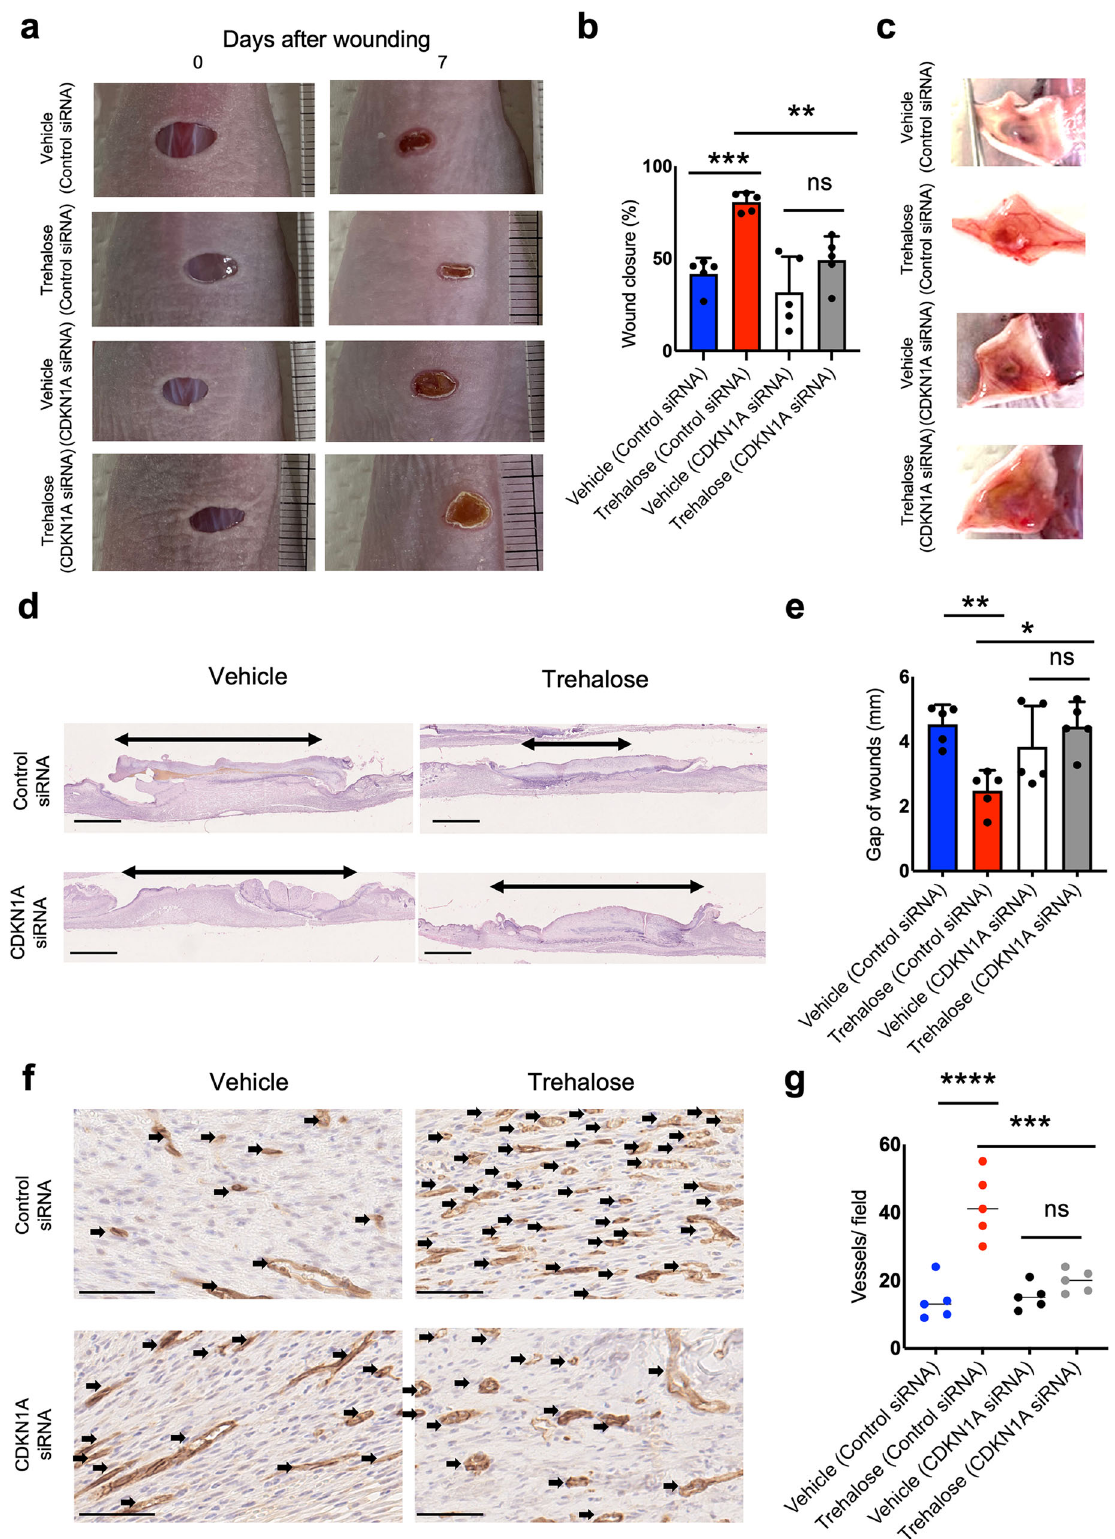
by siRNA, results in G2/M arrest and senescence in vitro 28 . P21 inhibits AURKA by regulating E2F3 29 . Hence, under the stress of high-concentration trehalose, induced transcription of CDKN1A inhibited AURKA, which led to the G2/M blockade (CDK1- induced mitotic entry). Furthermore, upstream analysis of RNA-seq data revealed the involvement of ZBTB17, which binds to